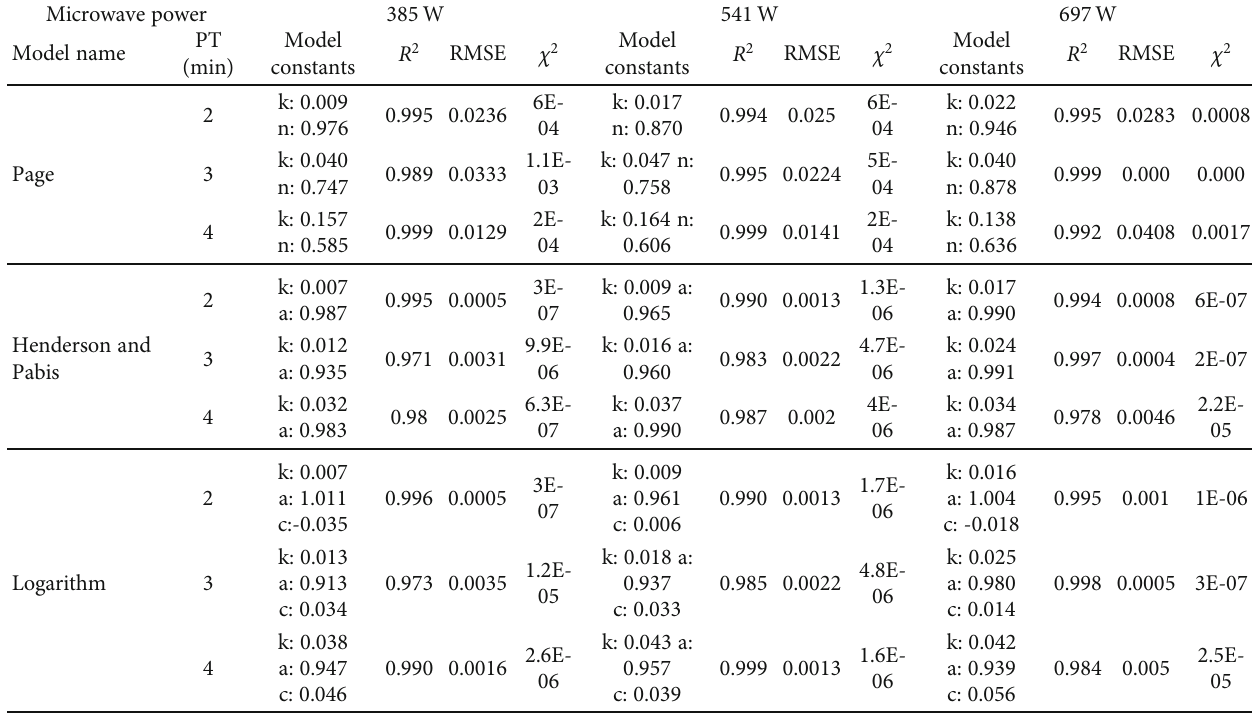
Table 3: Parameters and statistical results for the various drying models for microwave-assisted drying at 70 ° C. Microwave power